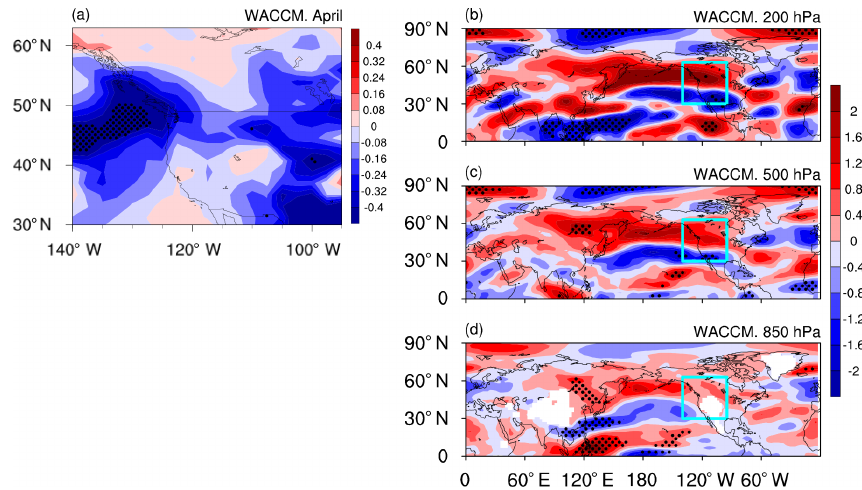
Figure 10. Same as Fig. 7, but for the difference between experiments R5 and R4.